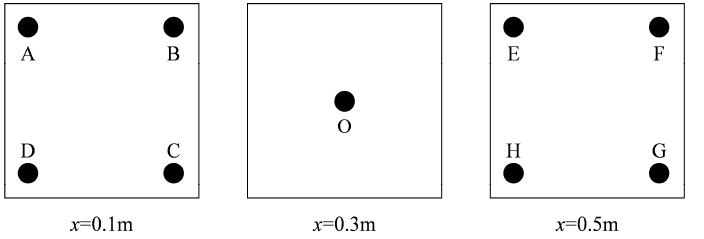
Figure 12. Layout of measuring points in the test section.